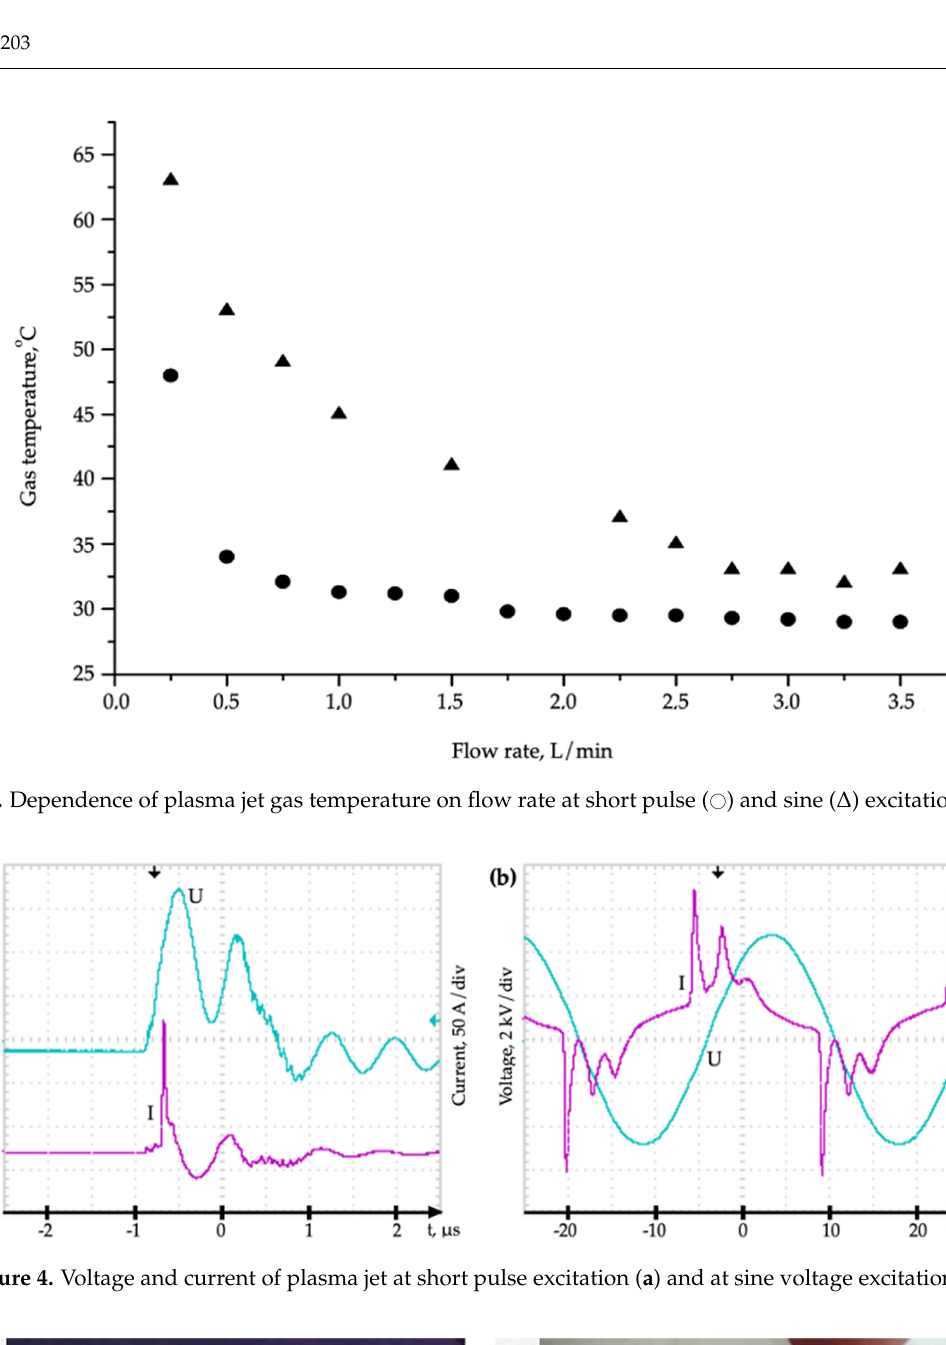
Appl. Sci. 2021 , 11 , x FOR PEER REVIEW Figure 4. Voltage and current of plasma jet at short pulse excitation ( a ) and at sine voltage excitation ( b ). Figure 4. Voltage and current of plasma jet at short pulse excitation ( a ) and at sine voltage excitation ( b ). Figure 4. Voltage and current of plasma jet at short pulse excitation ( a ) and at sine voltage excitation ( b ).